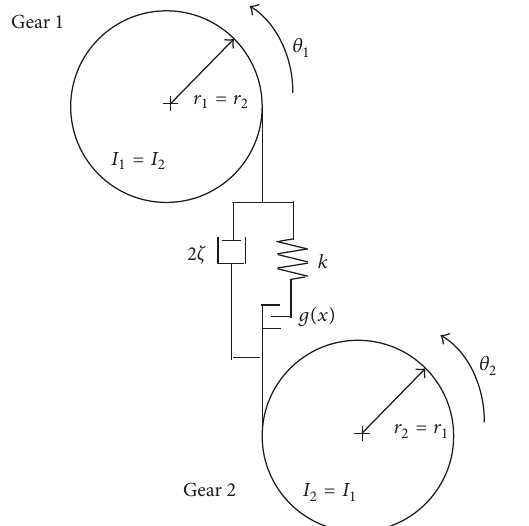
Figure 6: Dynamic representation of the 1D model of meshing cylindrical